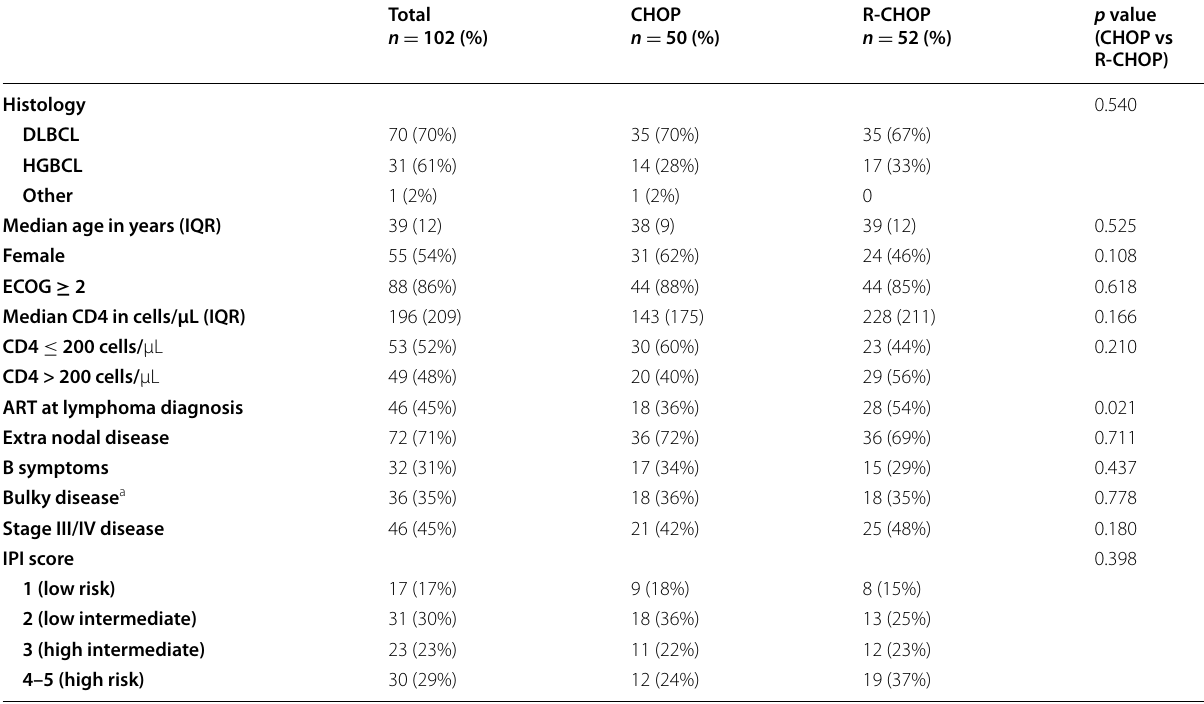
Table 1 Baseline profile of patients with CD20‑positive HAL presenting to King Edward VIII Hospital from 2006 to